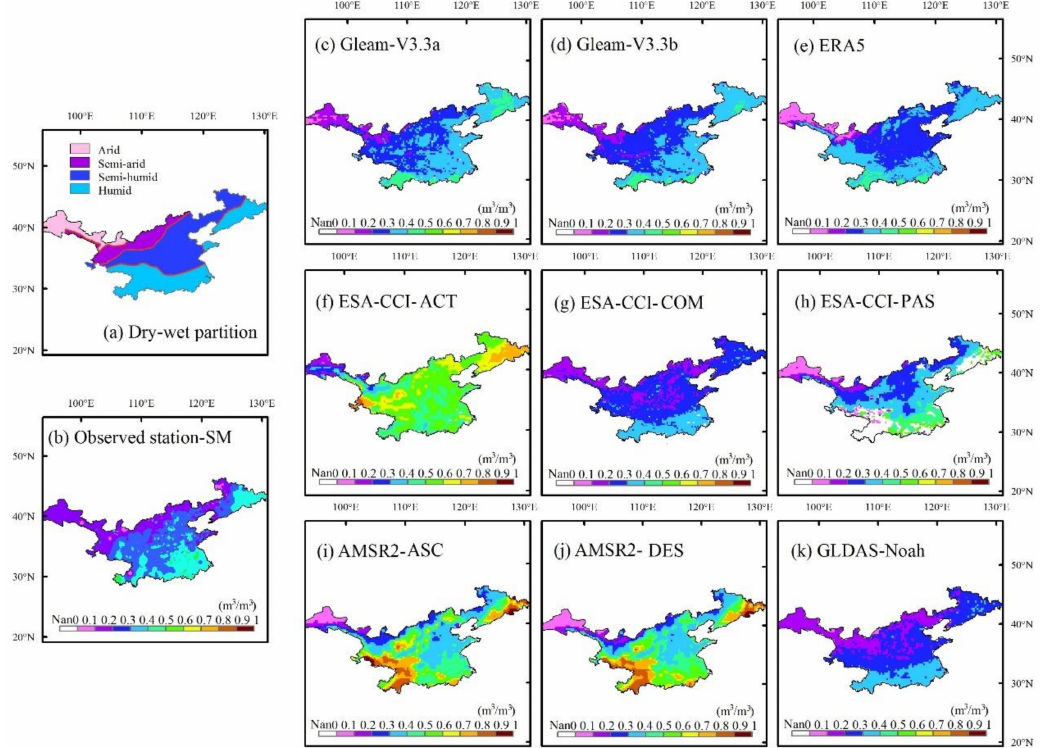
Figure 4. Spatial performances of nine multi-source satellite SM products compared to the in situ ground observations. (Note that the dry–wet area partition was also used herein as an assisting reference to overview the spatial performances of nine SM products on capturing different wet–dry